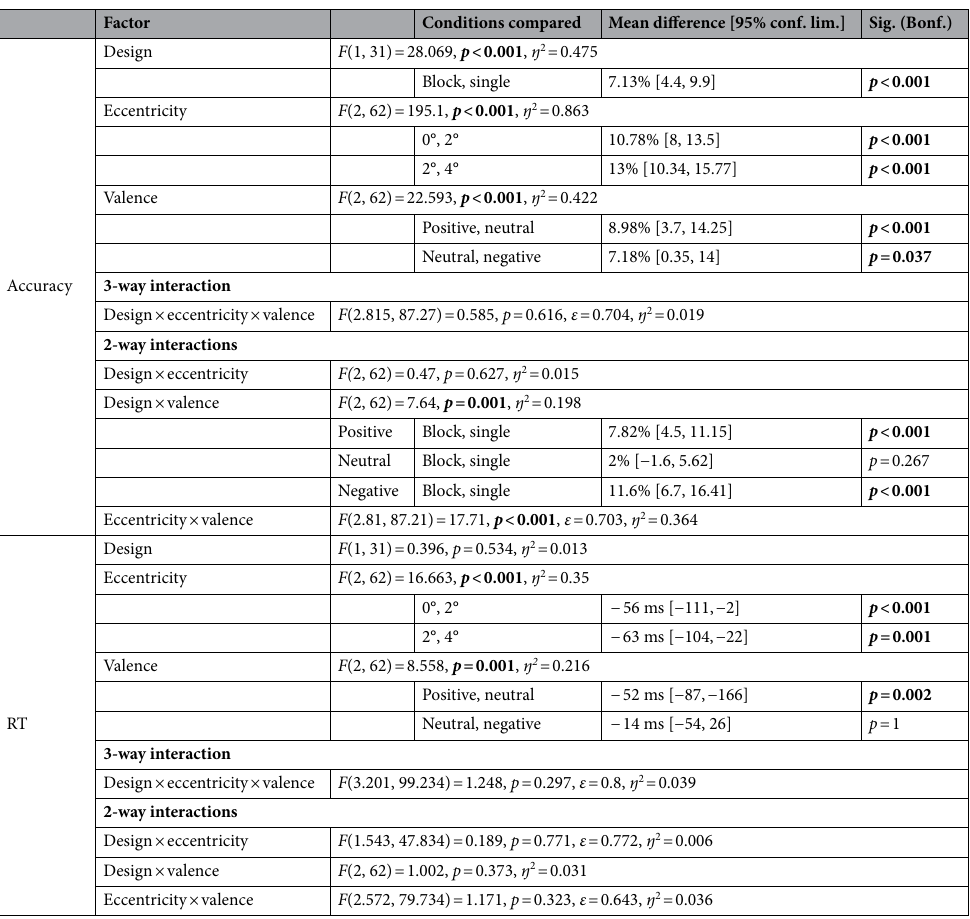
Table 3. Block-design vs single-trial within-subject statistical comparisons (n = 32). Results of two 2 × 3 × 3 3-way repeated-measures ANOVAs (one for accuracy, one for RTs), each with experimental design (block/ single-trial), eccentricity (0°, 2°, 4°), and valence (positive/neutral/negative) as within-subject factors (n = 32 that participated in both experiments). Post-hoc analyses with Bonferroni corrections, significant